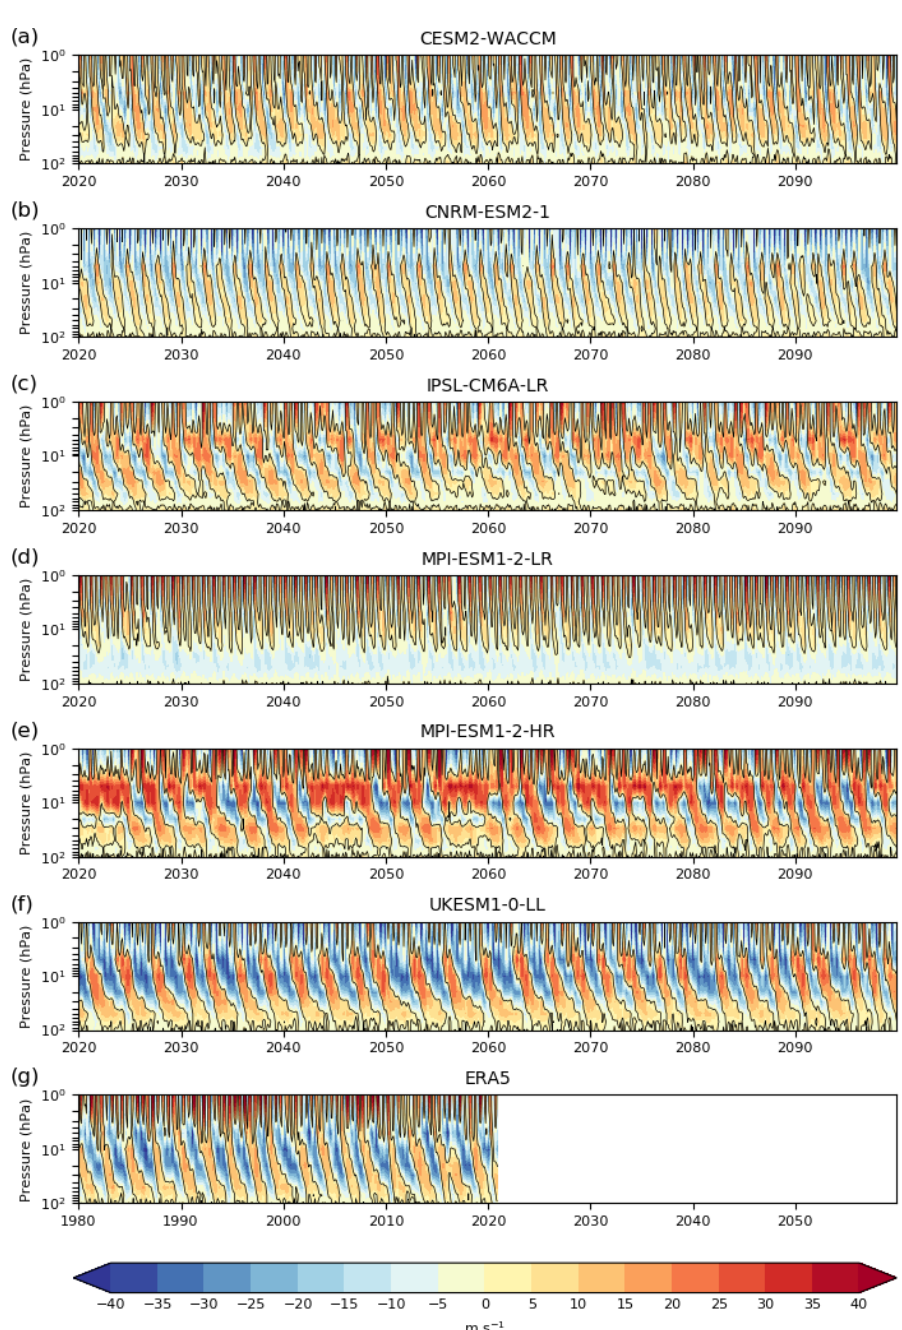
Figure 7. Time-pressure cross-sections of 5 ◦ N–5 ◦ S mean zonal stratospheric winds (ms − 1 ) from the first ensemble member of each model’s ssp245 simulation (a–f) and using ERA5 data (g) . The ERA5 plot was generated using Copernicus Climate Change Service information (Hersbach et al., 2019). Positive values indicate westerly winds and negative values indicate easterlies; the black contour is at 0ms − 1